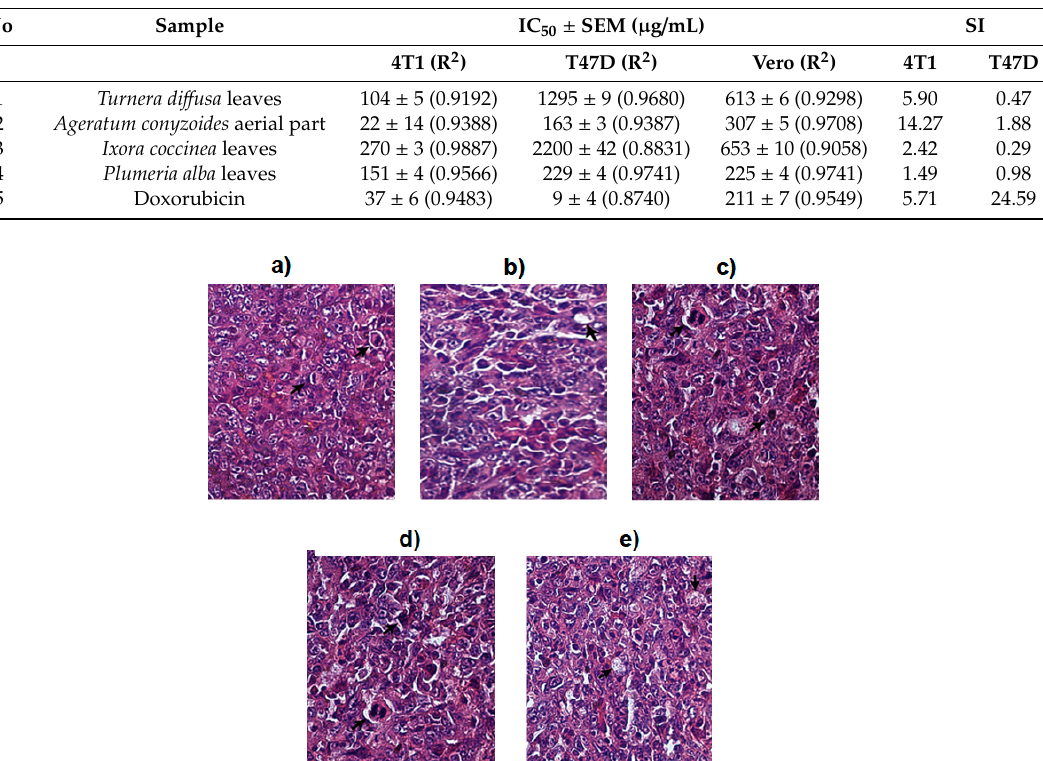
Figure 5. The 4T1 cell morphologies after and before treating with four top active extracts as followed; ( a ) untreated cell, ( b ) Ixora leaves, ( c ) Turnera leaves, ( d ) Ageratum aerial part, and ( e ) Plumeria leaves. The arrow indicates the living cell for the white nodes whereas the death cell is black node surrounded by white line.